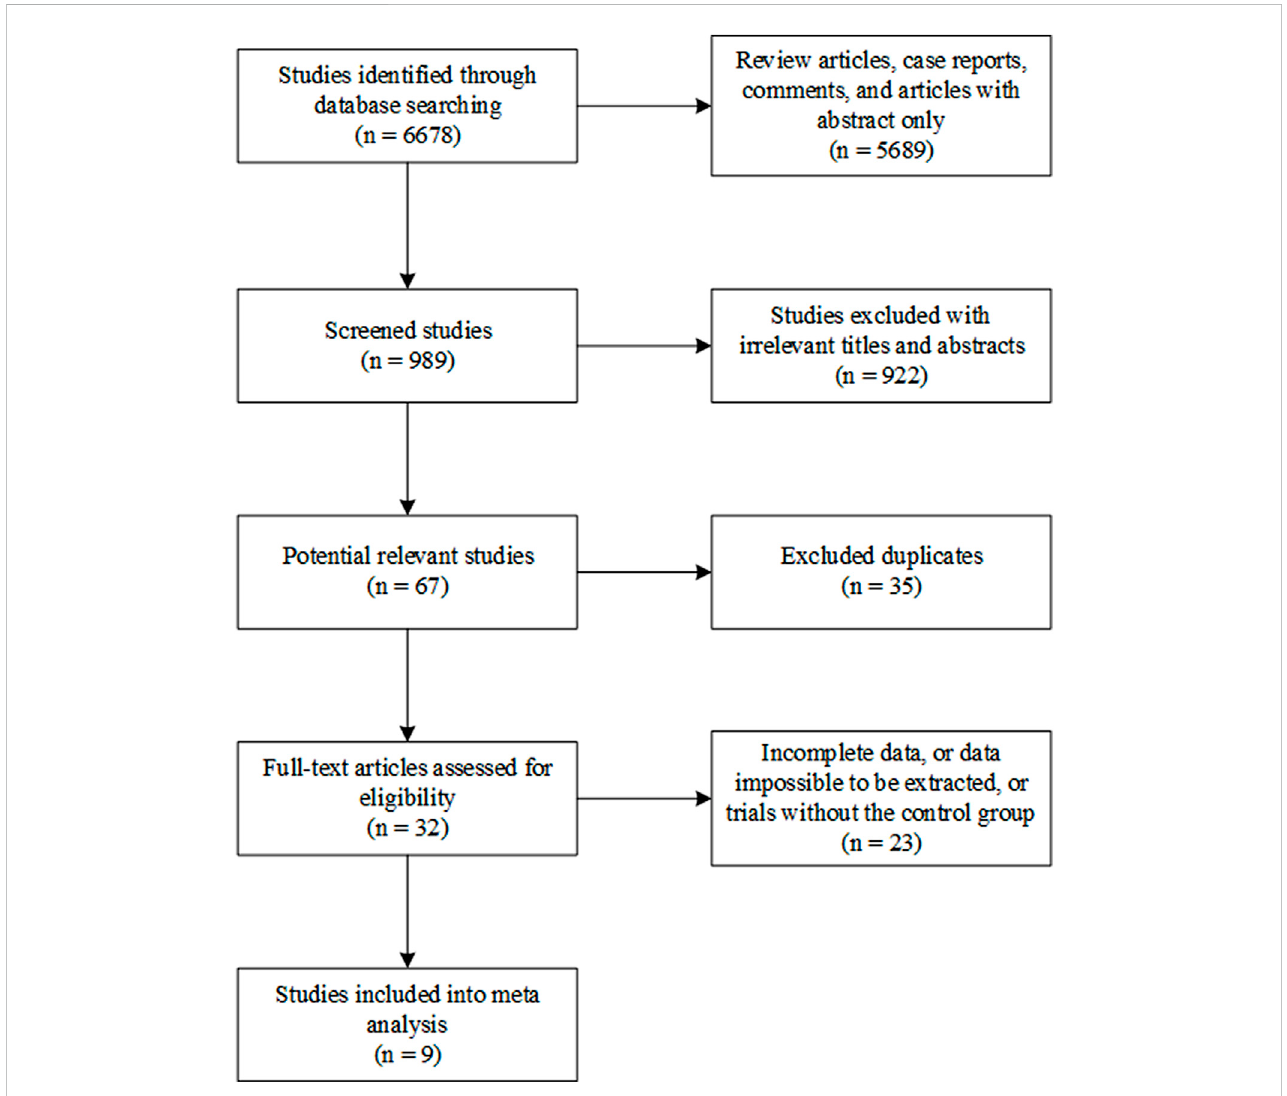
FIGURE 1 Flow chart of study selection including inclusion and exclusion